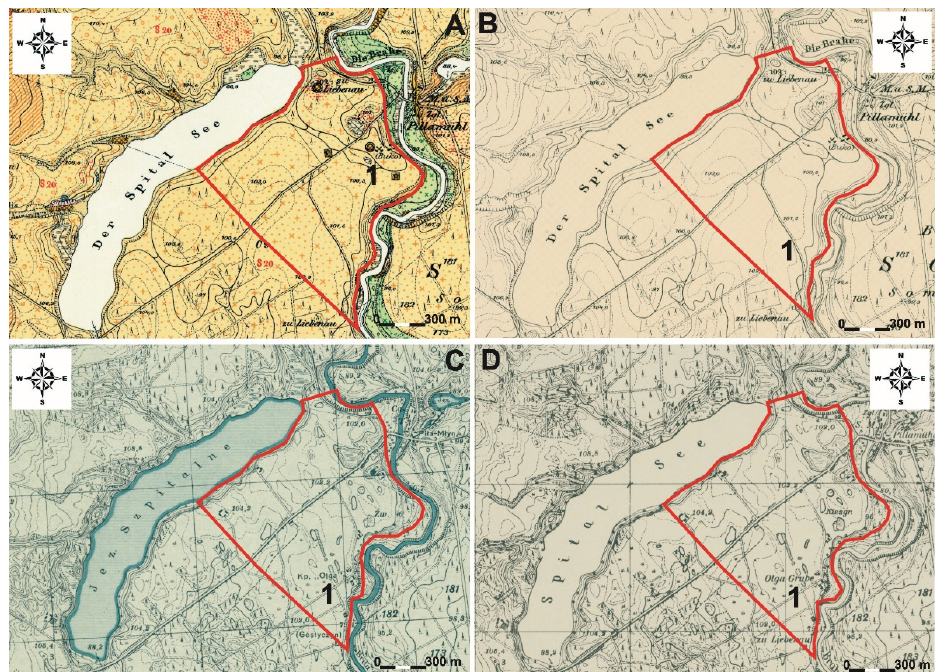
Figure 3. Historical topographic maps. ( A )—German geologic-agricultural map from 1905, Tuchola sheet, ( B )—German topographic map from 1930, Tuchola sheet, ( C )—Polish topographic map from 1933, Bysław sheet, ( D )—German topographic map from 1940, Tuchola sheet. A 1—localization of Buko mine, B 1– D 1—localization of Olga mine, source [29].